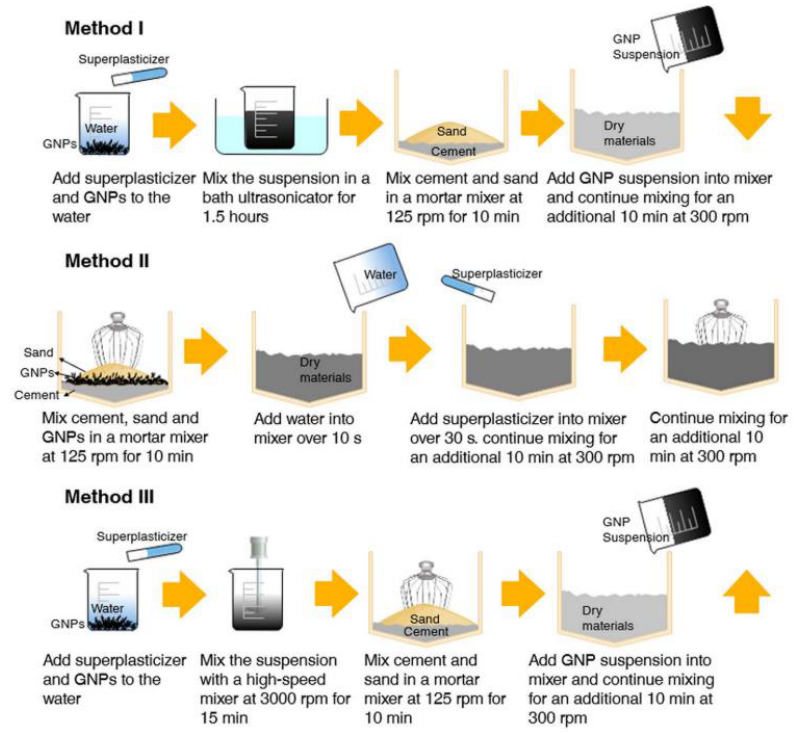
Figure 6. Mixing methods for graphene fillers in cement matrix. Reprinted with permission from Ref. [71]. Copyright 2018 IOP Publishing.